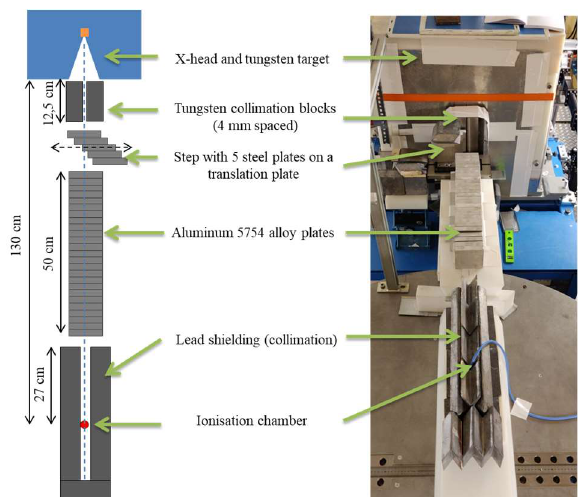
Fig. 9. Experimental set-up for transmission measurements with the SATURNE